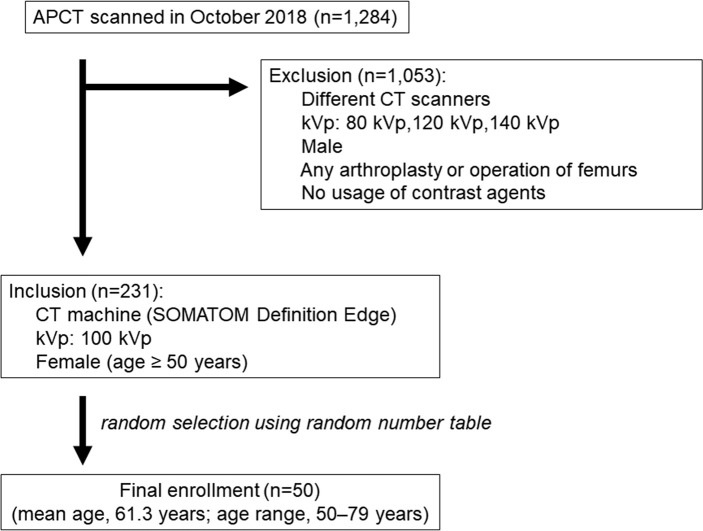
Flowchart of patient selection.APCT = abdominopelvic CT.